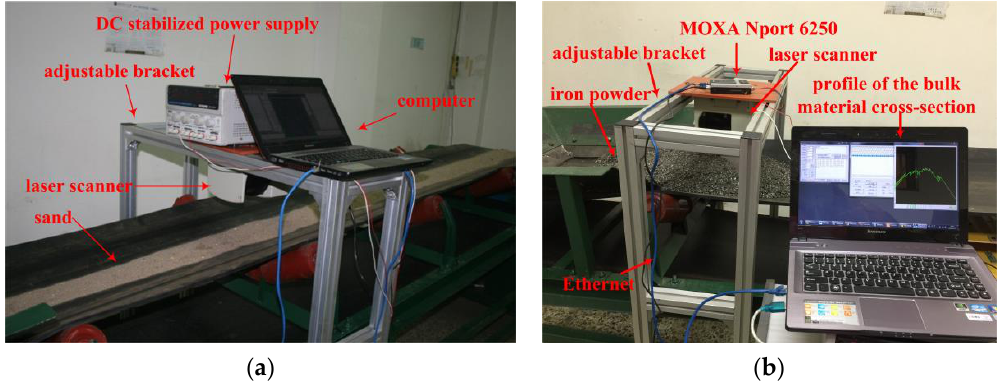
Figure 2. Experimental facility for measuring bulk material distribution. ( a ) Sand cross-sections measurement in real-time; ( b ) the fitting of iron powder cross-section in real-time.